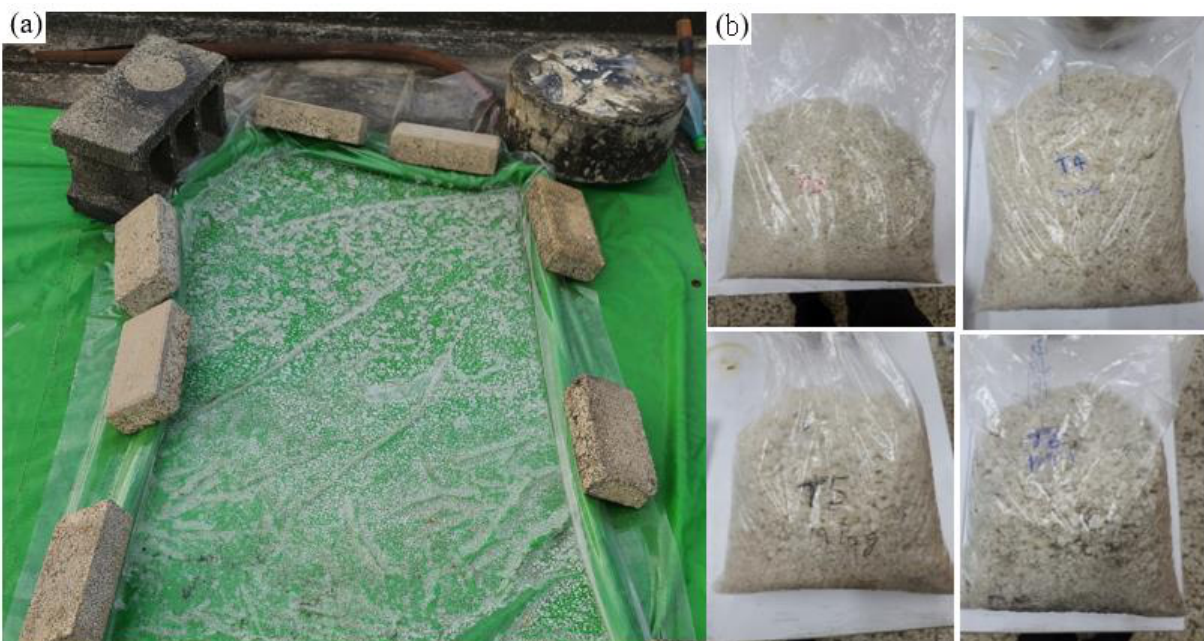
Figure 4. ( a ) Production of crude solar sea salt crystals from the evaporation of the brine residue. ( b ) Samples collected from different experimental trials.